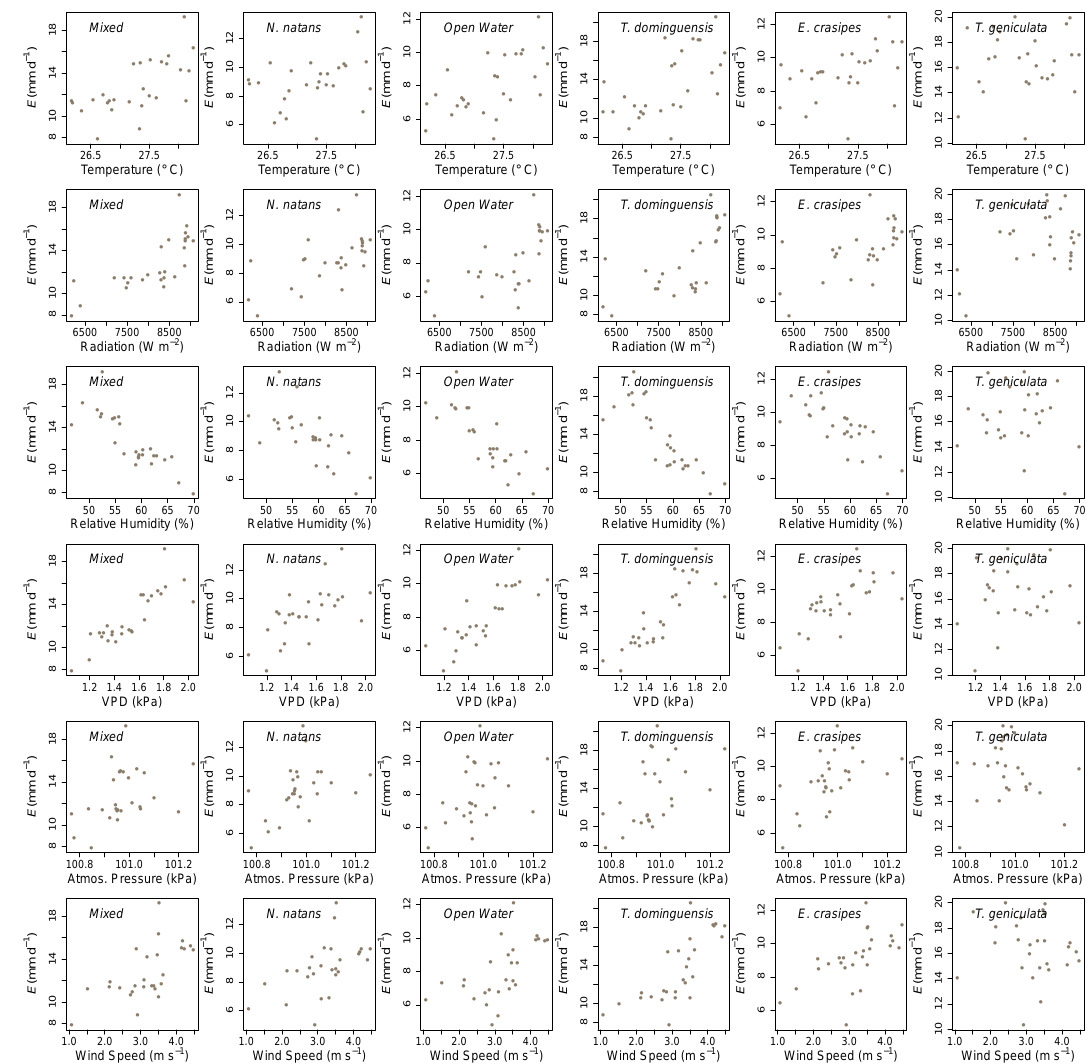
Figure A2. Pearson correlation matrix among the evaporation rates of the selected wetland covers and daily averages of the measured meteorological